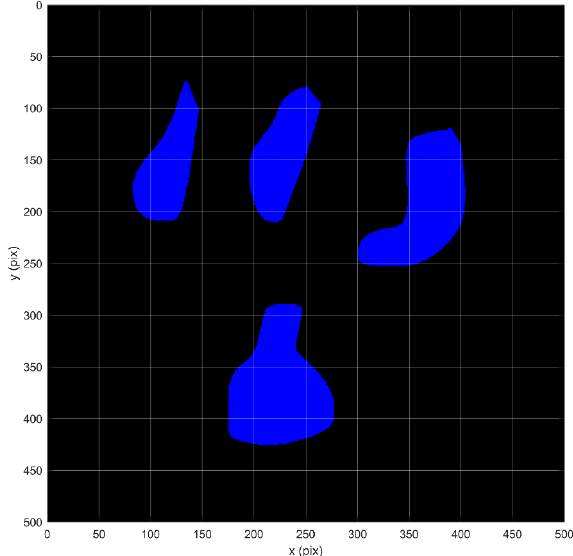
Figure 1. The example of the two-dimensional terrain map considered in this work. The dark blue color stands for the obstacles, i.e., areas where a sensor cannot be located and where there is no need for patrolling procedure. The black color stands for the area where it is required to realize patrolling procedure and a sensor can be located. The white grid that marks ticks with the step of 50 pixels is used for the visual reference and does not relate to the discussed problem.